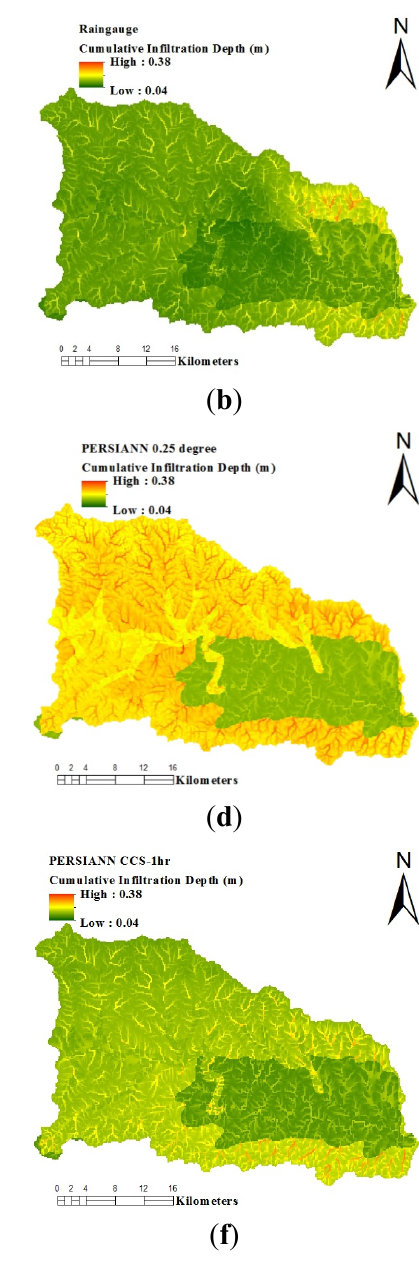
Figure 13. Spatial distribution of cumulative infiltration depths (m) driven by different precipitation products for the July 2007 event: ( a ) radar; ( b ) raingauges; ( c ) TRMM 3B42V7;